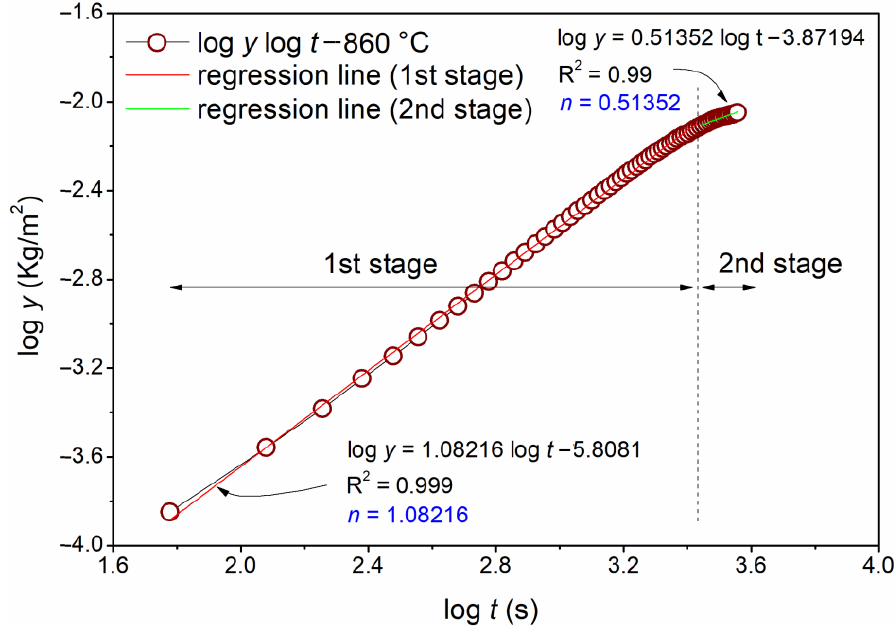
Figure 7. Log of the mass variation per unit surface area as a function of the exposure time for the Ni-based alloy at 860 °C to determine the oxidation rate index ( 𝑛 ) for the two different oxidation stages.